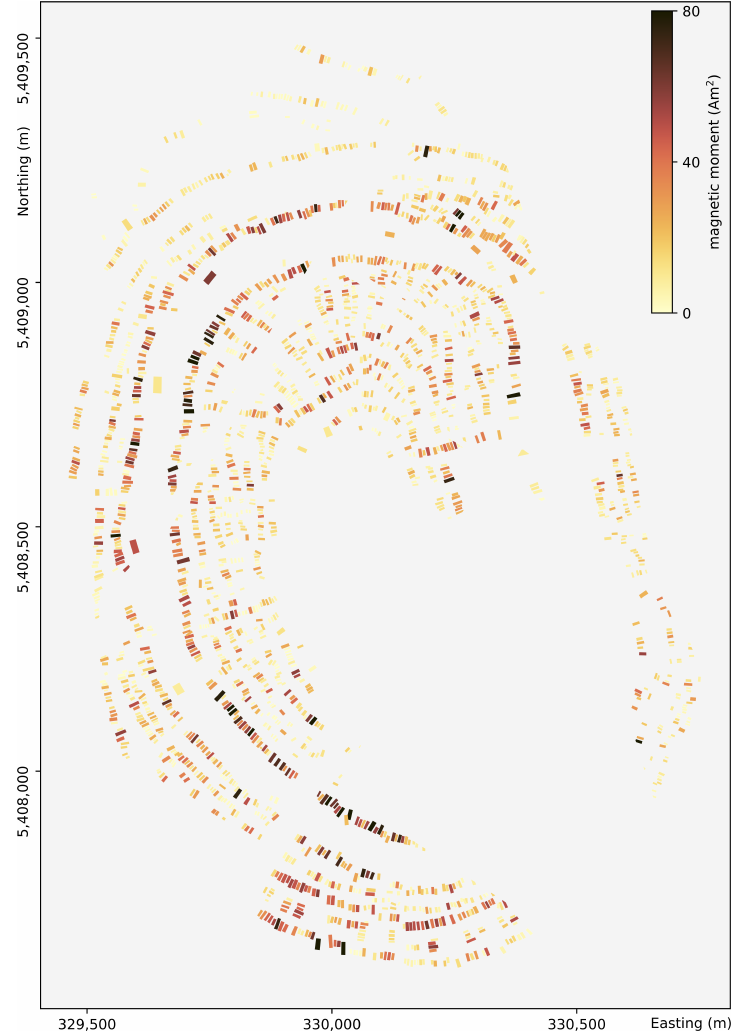
Figure 11. Magnetic moment of each building derived from the magnetization